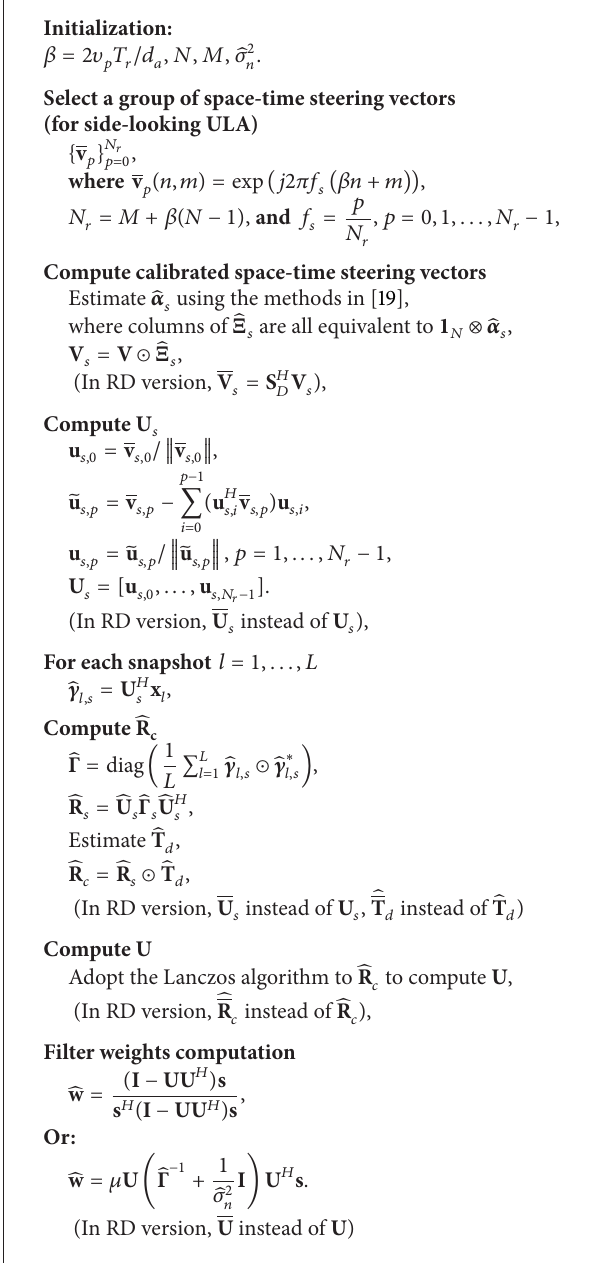
Algorithm 1: The proposed KA-STAP